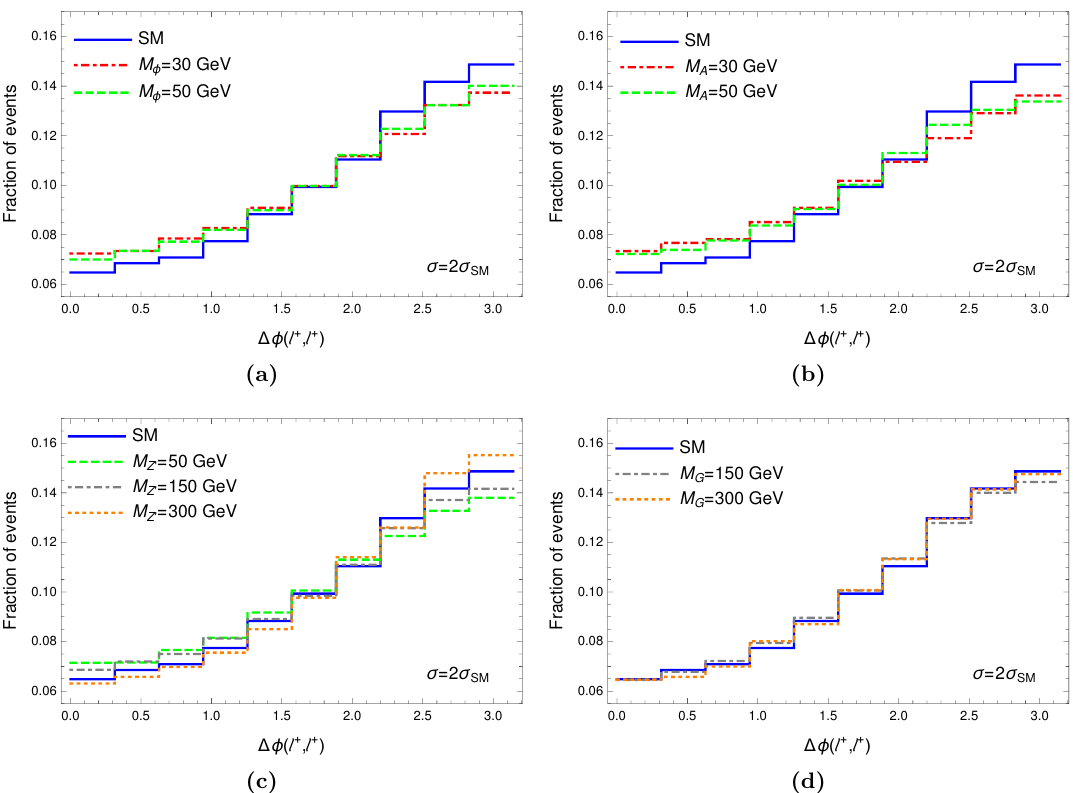
Figure 10. Distribution of the azimuthal separation between the same-sign leptons, (cid:1) (cid:30) ( ‘ + ; ‘ + ), for the 2LSS channel after preselection (see text for details), normalized to unit area. Shown are the predictions for the SM (blue) and the loose benchmark points (i.e. giving (cid:27) = 2 (cid:27) SM ) of the NP models considered: (a) Scalar, (b) Pseudo-scalar, (c) Z 0 , and (d) Graviton. Analogous results for the tight benchmark points (i.e. giving (cid:27) = 1 : 5 (cid:27) SM ) are shown in (cid:12)gure 7.